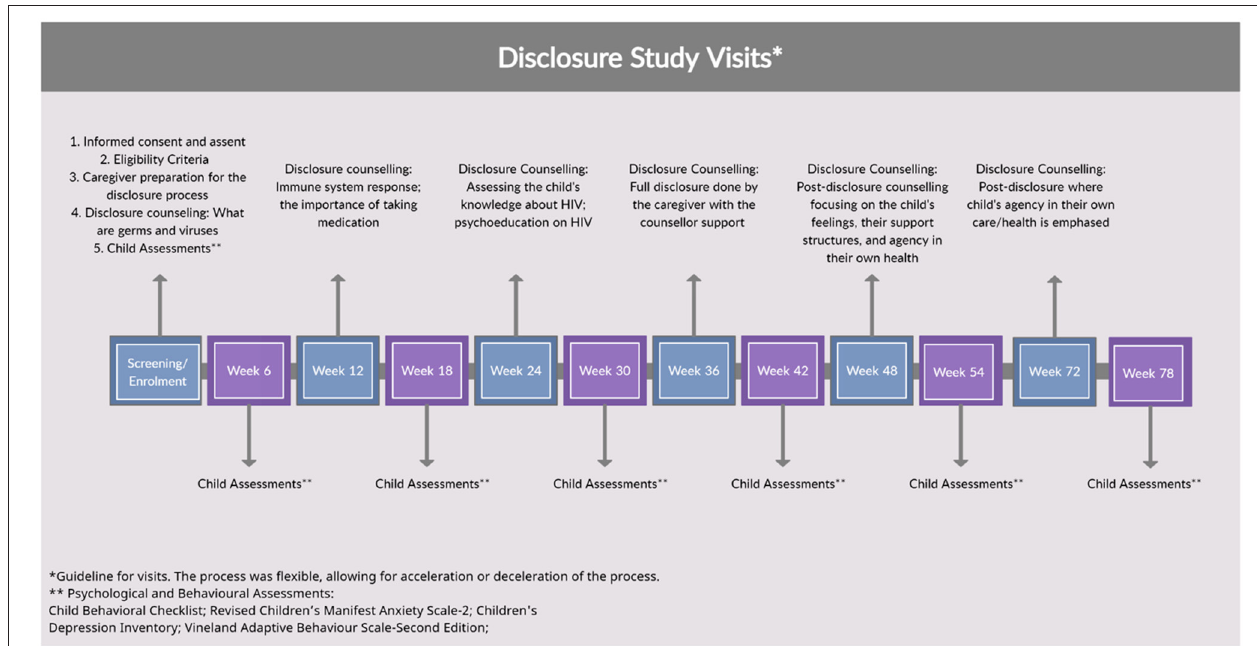
FIGURE 1 | The disclosure study visit guideline for the 13 sessions conducted over 78-weeks, and what each visit entailed.